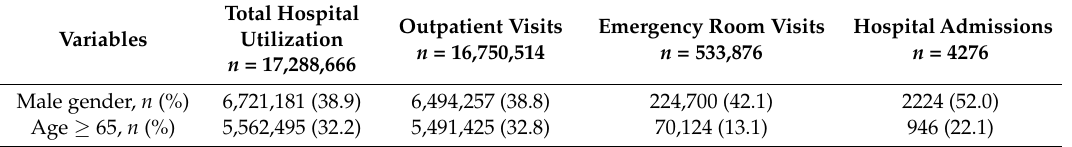
Table 1. Demographic feature of upper respiratory tract infections (URTI)-related hospital utilization from 1 October 2010 to 30 September 2012 in Beijing,